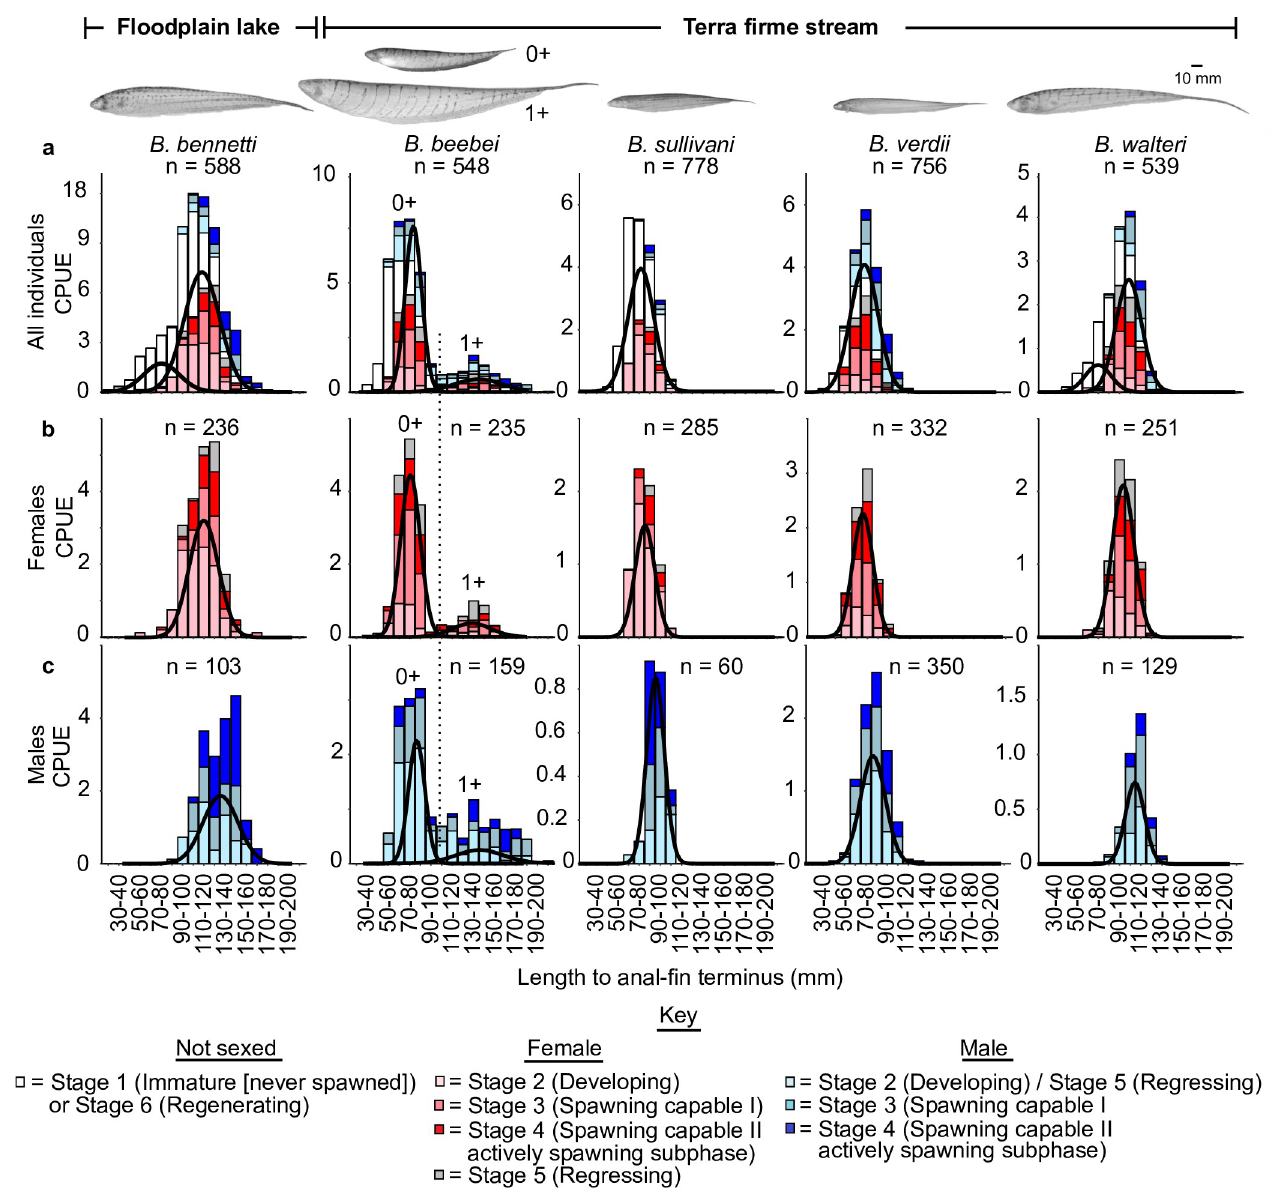
Fig 3. Size-frequency distributions for five species of Brachyhypopomus pooled over the 12-month study period with Gaussian distributions fitted by finite mixture models to show modal size groups. a. Unsexed immature/regressing individuals, females, and males combined (i.e. gonad maturation Stages 1–6). b. Females only (gonad maturation Stages 2–5). c. Males only (gonad Stages 2–5). CPUE = capture per unit effort in individuals � hr -1 . Vertical dotted line shows that the cut-off between the putative 0+ and 1+ year groups of B . beebei at 115 mm LEA is the same for males and females. Stage 6 (regenerating) individuals are confined to the 1+ year group of B . beebei